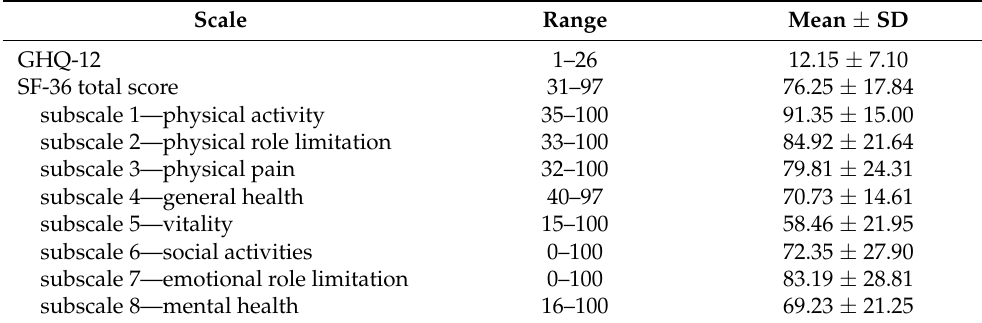
Table 2. Questionnaire scores on mental and general health.